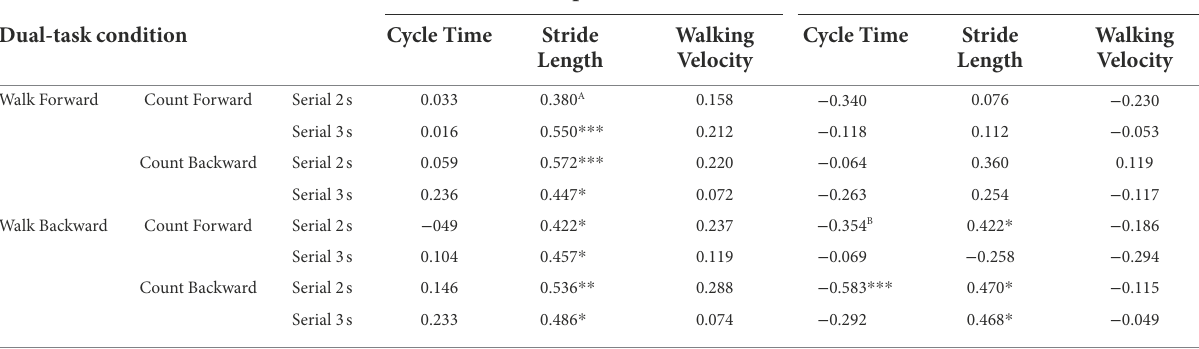
TABLE 2 Correlations between motor performance variables (cycle time, stride length, and walking velocity) and cognitive performance (counting fluency) for the dual-task conditions, and the dual-task